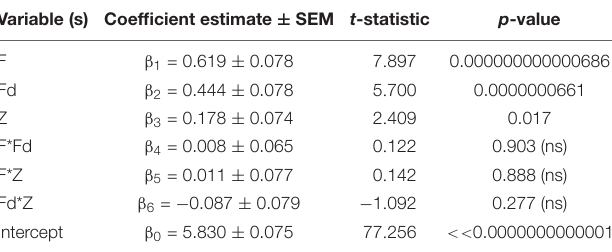
TABLE 4 | Regression model of interest rating (I) as a function of F, Fd, and Z I = β 0 + β 1 *F + β 2 *Fd + β 3 *Z + β 4 *F*Fd + β 5 *F*Z + β 6 *Fd*Z. Variable (s) Coefficient estimate ± SEM t